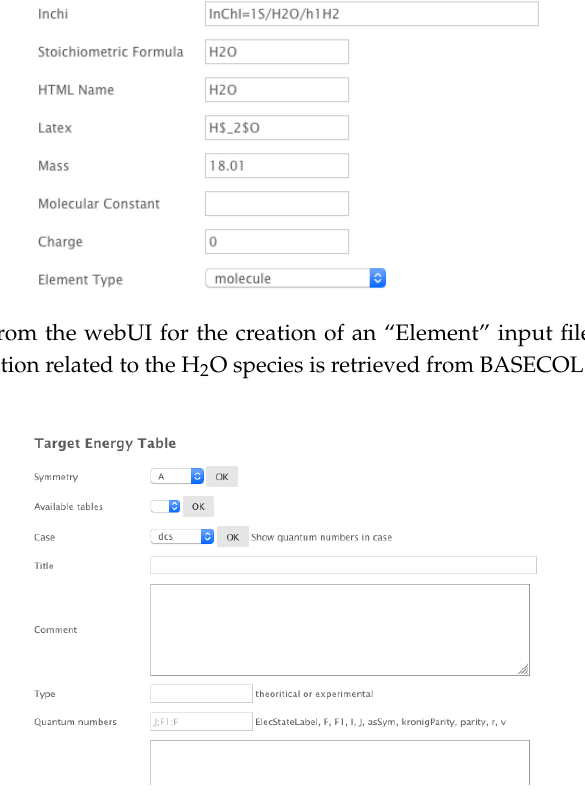
Figure A2. Extract from the WebUI for the creation of an “Energy Table” input (Table A2). In this example, the information related to the case “dcs” (diatomic close shell molecules) is retrieved from BASECOL. On the right of the “Quantum numbers” box, a list of quantum numbers appears. The administrator chooses the relevant quantum numbers and includes them in the